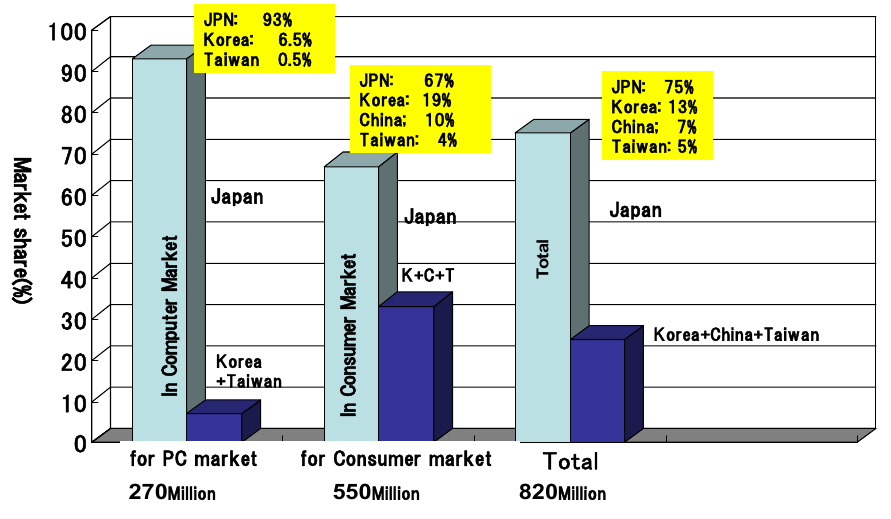
Figure 6. Market Share of Optical Pick-up by Country (year